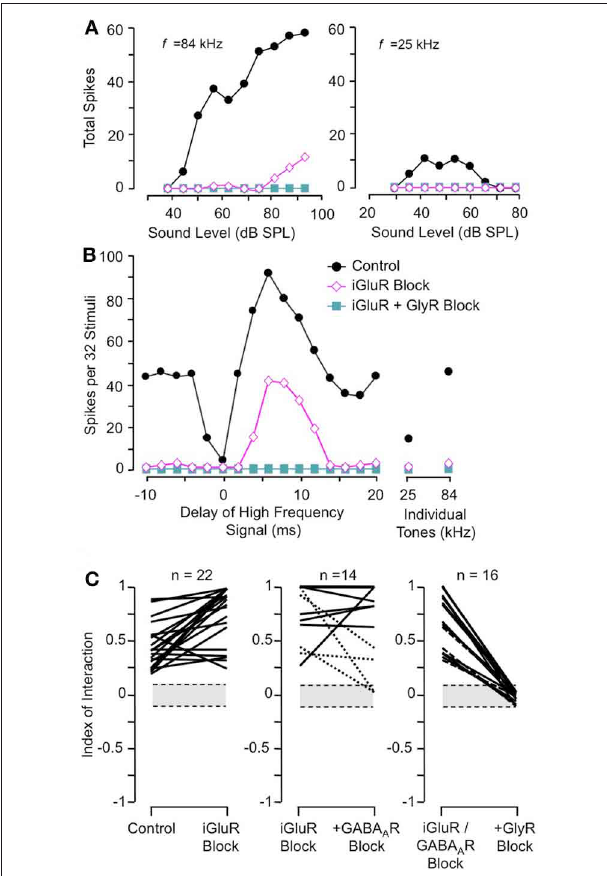
FIGURE 10 | Glutamate receptors (iGluRs) play no role in combination-sensitive facilitation. (A) Responses to ChF and low-frequency tones are eliminated by iGluR blockade. (B) Blockade of iGluRs eliminated excitatory responses to single tones, but facilitated combination-sensitive responses persisted. Only the application of a GlyR blocker eliminated facilitatory interactions. (C) Effects of receptor blockade on low-frequency facilitation among IC neurons. In all neurons, iGluR blockade failed to eliminate facilitation, but GlyR blockade always eliminated facilitation. Blockade of GABA A Rs generally did not eliminate facilitation. Adapted from Sanchez et al. (2008), with permission.